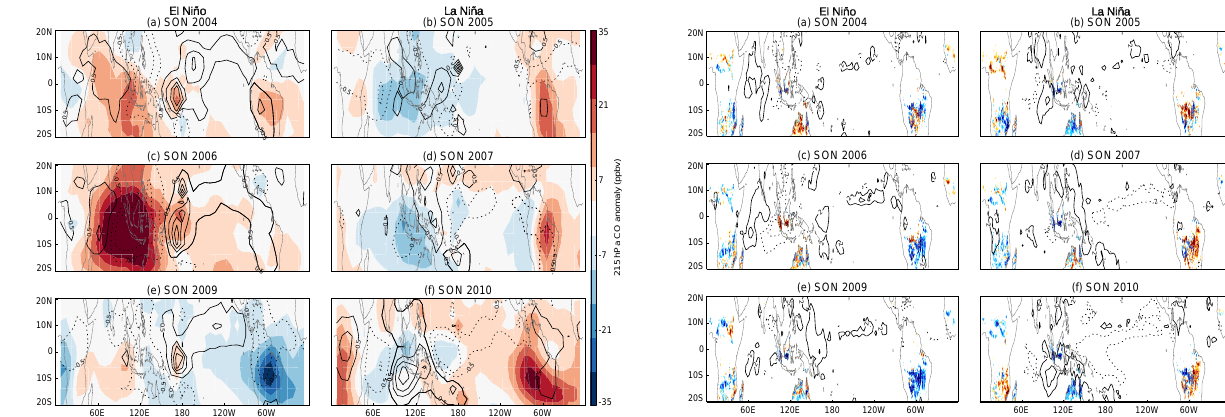
Fig. 6. Seasonal (SON) mean distributions of CO (shaded con- tour) and IWC (line contour) anomalies in the upper troposphere (215hPa) during (a) 2004, (b) 2005, (c) 2006, (d) 2007, (e) 2009 and (f) 2010. The IWC contour interval is 1mgm − 3 . The solid line represents positive IWC anomaly, and the dotted line represents negative IWC anomaly.